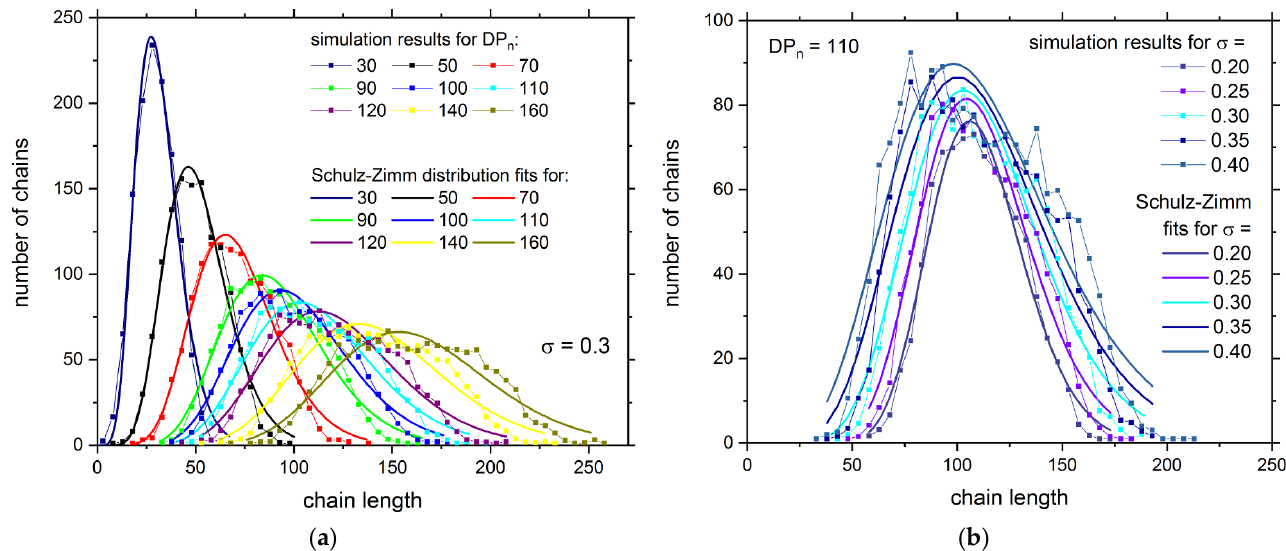
Figure 2. The distribution of chain lengths in opposing brushes for different degrees of polymerization DP n ( a ) and for different grafting densities σ ( b ). The points connected with thin lines represent Monte Carlo simulation results, whereas thick lines show the Schulz–Zimm approximations.